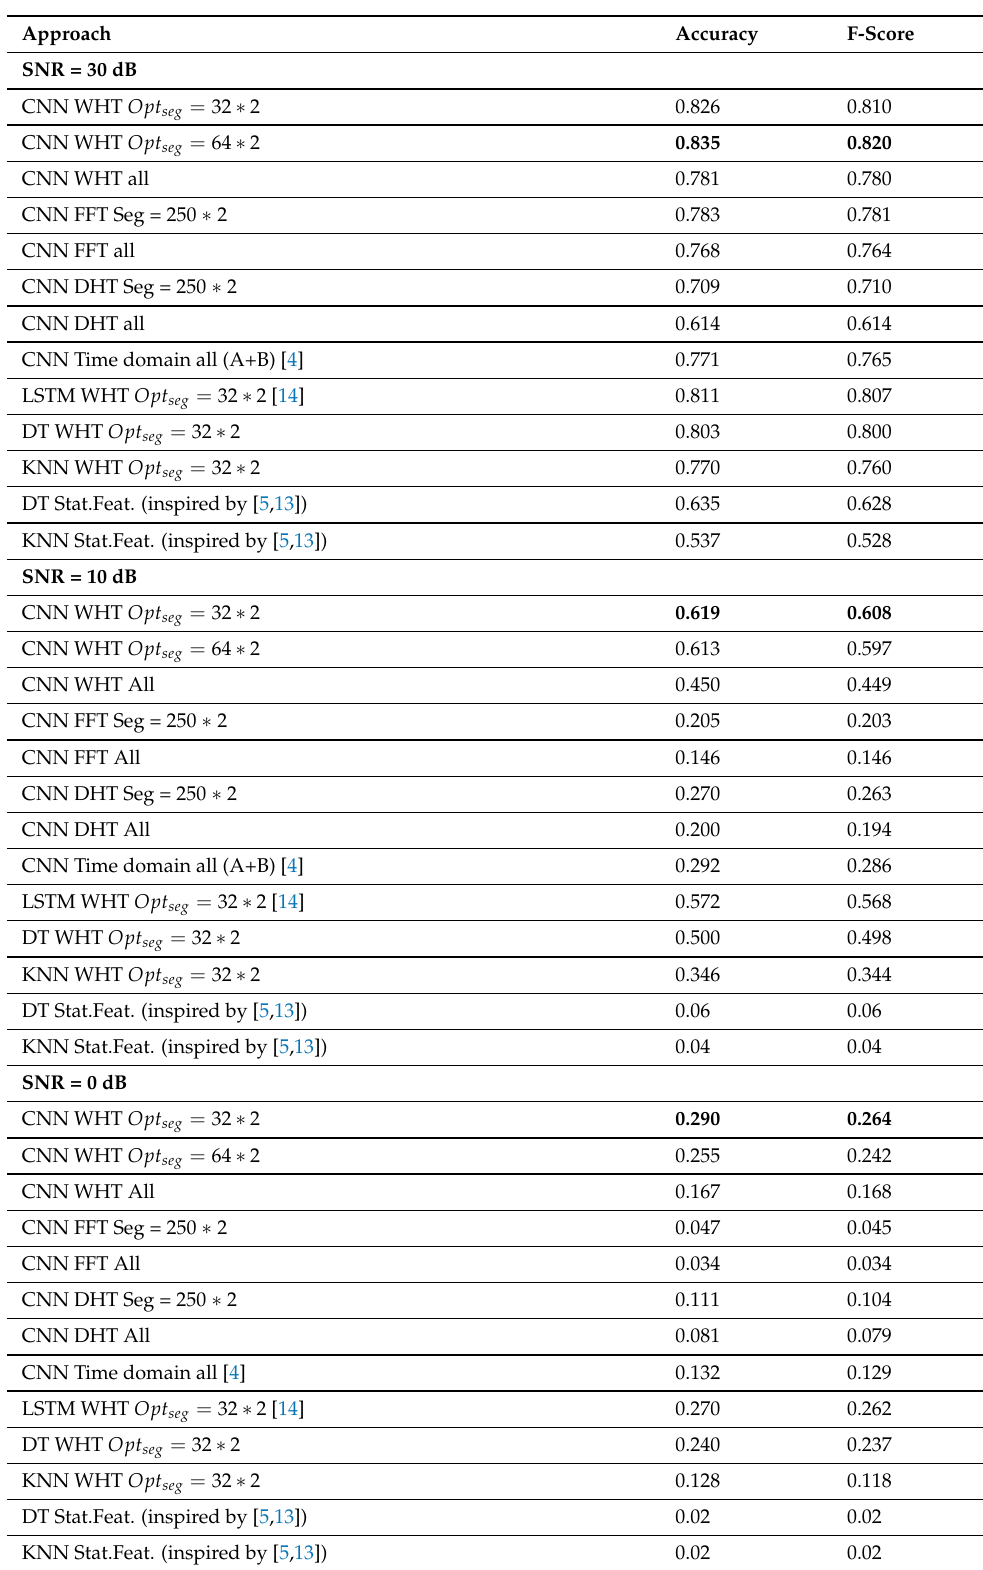
Table 2. Detailed report on the comparison of the different approaches. Both voltage A and voltage B have been